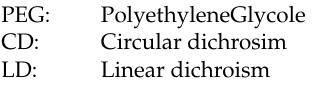
Figure S1: Normalized absorption spectra of bis-Ru-bpp bound to poly[d(A-T)2], poly[d(G-C)2] and poly[d(I-C)2] DNA. [DNA]= 100 µ M, [bis-Ru-bpp] = 2.0, 4.0, 6.0, 8.0, 10.0 µ M . The absorption spectra of DNA were